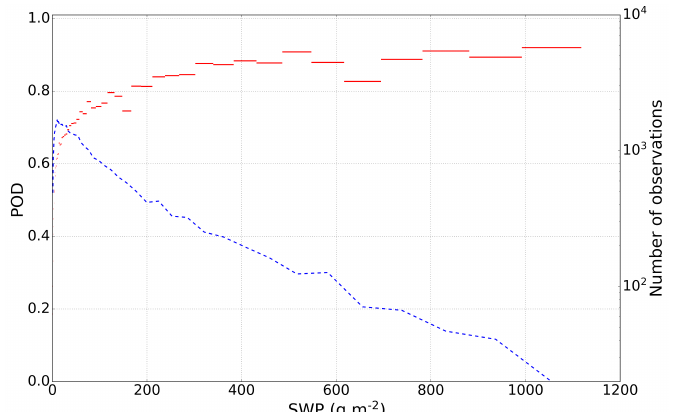
Figure 8. Probability of detection (POD) as a function of SWP with logarithmically-scaled bins in red. The blue line corresponds to the number of observations in each bin plotted on a logarithmic axis.